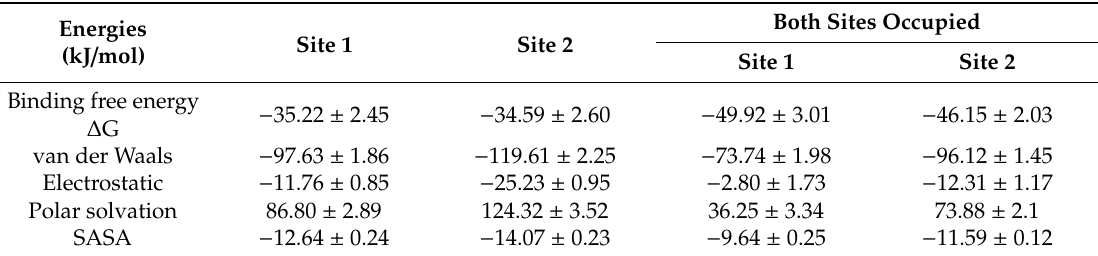
Table 3. Energies obtained from molecular mechanics Poisson Boltzmann surface area (MM / PBSA) for piperine occupying both sites and for piperine occupying just one site. Van der Waals, Electrostatic, polar solvation and SASA were obtained from a PBSA calculation.